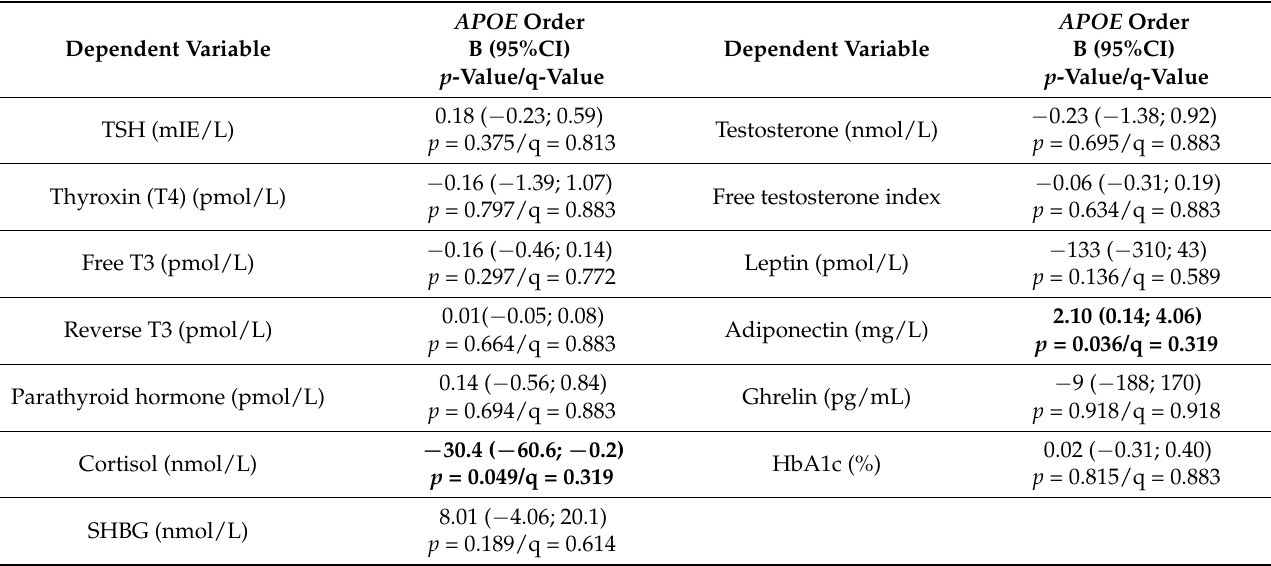
Table 3. Ordered APOE groups (E2-E3-E4) as a predictor of the hormones adjusted for age, gender, BMI and point of time (before/after surgery), analysed with linear mixed model. The q-values are Benjamini–Hochberg-adjusted p -values for 13 analyses between the APOE order and the